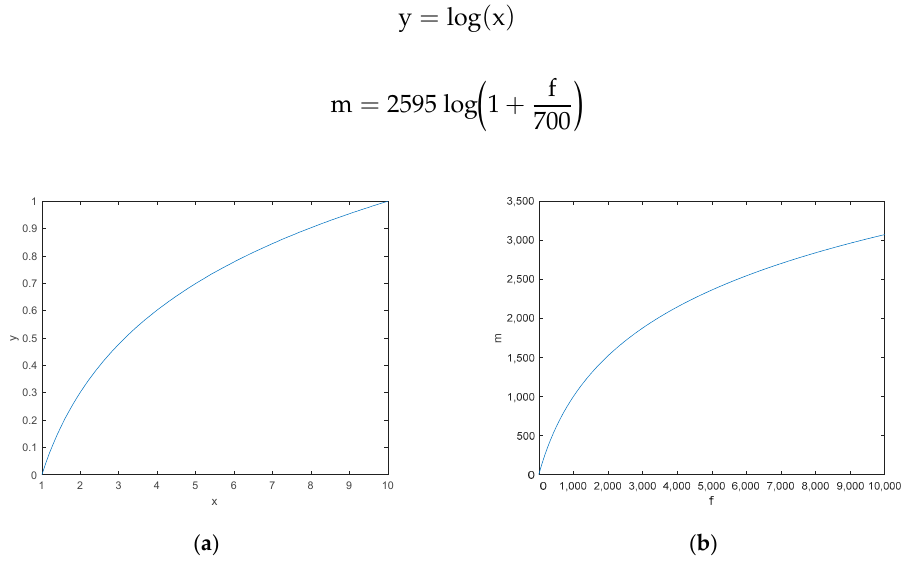
Figure 5. Scale mappings of the log and mel transforms; ( a ) Log; ( b ) Mel.